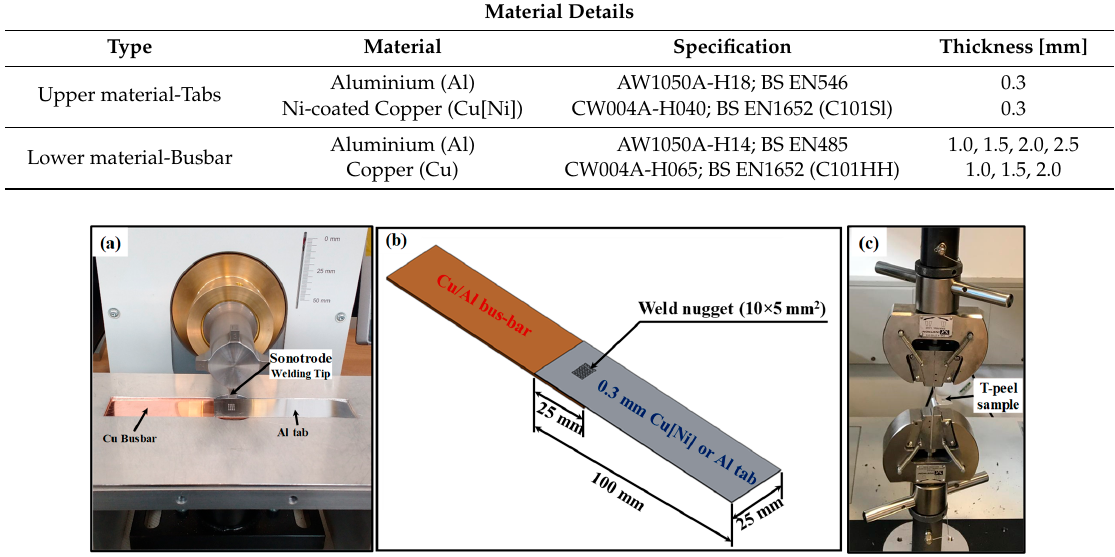
Figure 1. ( a ) Ultrasonic metal welding joining set-up; ( b ) a pictorial example of ultrasonic welding to produce tab-to-busbar interconnect in lap configuration; and ( c ) T-peel test set-up for mechanical strength characterisation.